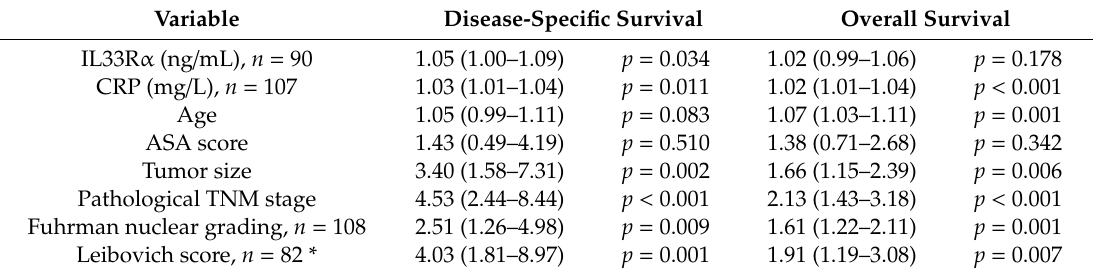
Table 2. Univariate Cox survival predictions in radically treated renal cell carcinoma patients using serum IL33R α and CRP, as well as the included clinico-histopathological parameters. Values are given as the hazard ratio (95% confidence interval). The whole patient cohort included 109 patients, but the IL33R α levels were analyzed for 90 randomly selected patients. Other values that di ff er from n = 109 are specified.